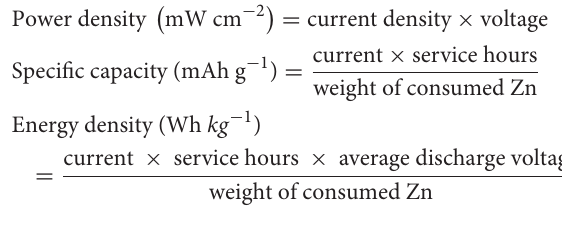
Frontiers in Materials |